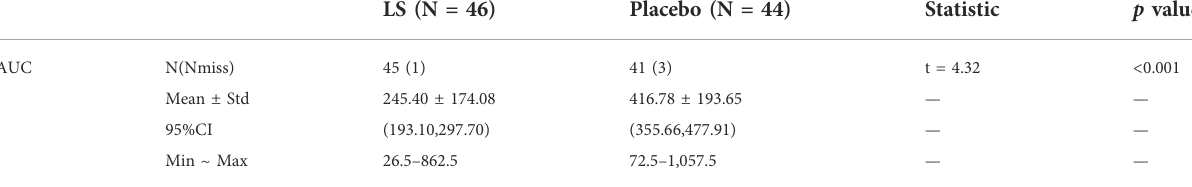
TABLE 3 The AUC of total in fl uenza symptom scores in two groups of participants